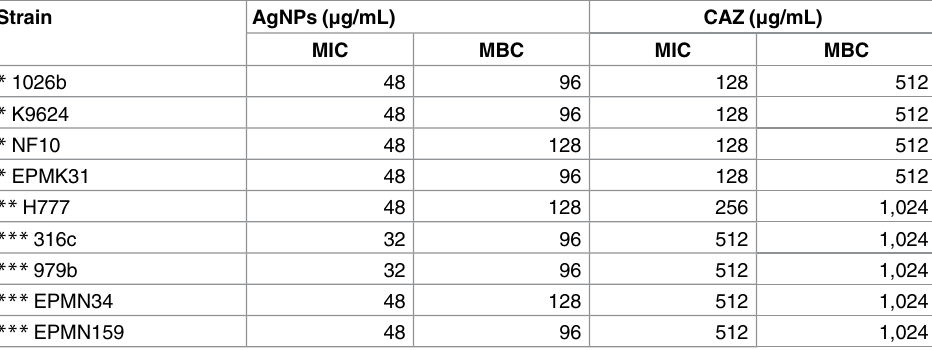
The MIC value corresponds to the concentration that inhibited > 99% of bacterial growth, and the MBC value corresponds to the concentration that inhibited 100% of the bacterial